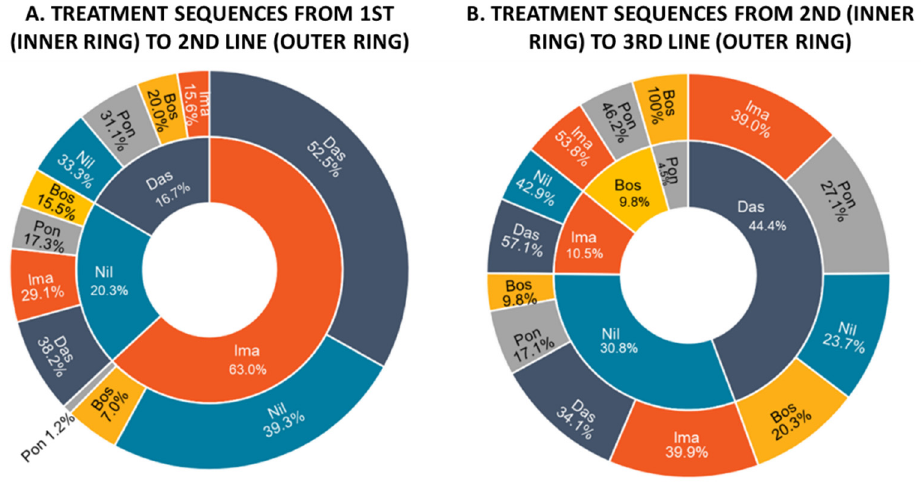
Figure 2. Treatment sequences from 1st (inner ring) to 2nd line (outer ring) ( A ) and from 2nd (inner ring) to 3rd line (outer ring) ( B ) considering all patients included in the analysis. Abbreviations: Bos, bosutinib; Das, dasatinib; Ima, imatinib; Nil, nilotinib; Pon, ponatinib. After a median follow-up of 3.0 and 2.6 years, the proportion of deceased patients was 13.2% and 19.4% in 2nd L and ≥ 3rd L cohorts, respectively (Table 3). Around 40% in both the cohorts, discontinued their treatment, with a median time to discontinuation of cohort (Figure 3).